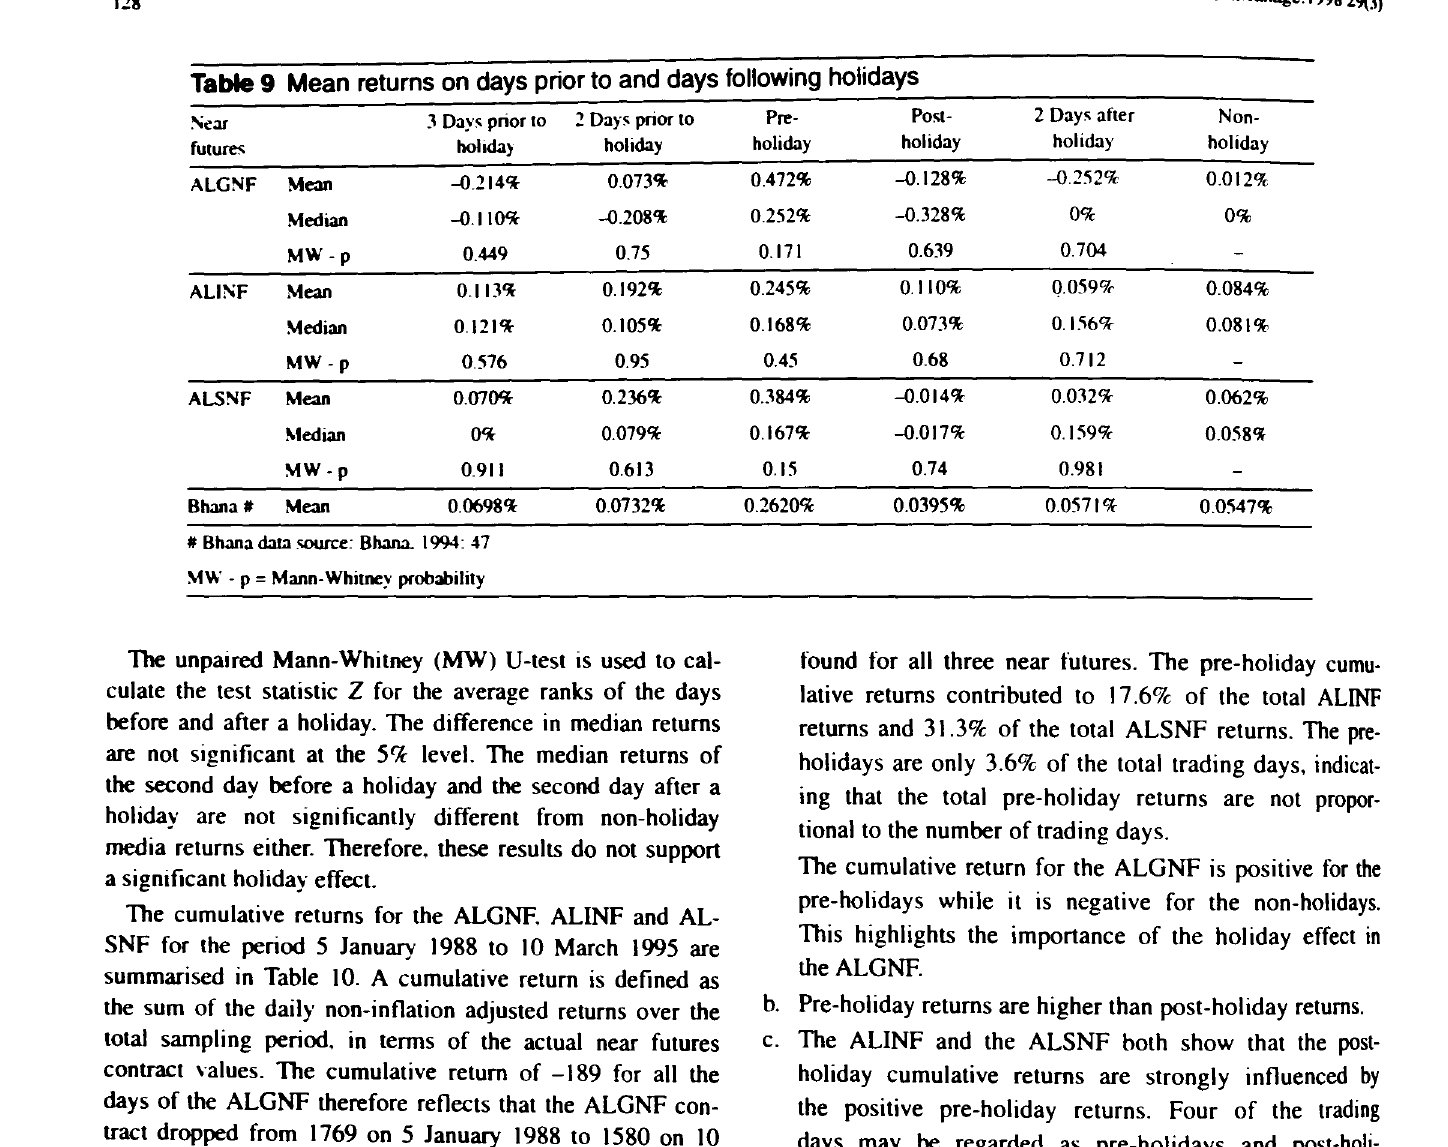
Table 10 Cumulative returns on near futures contracts for